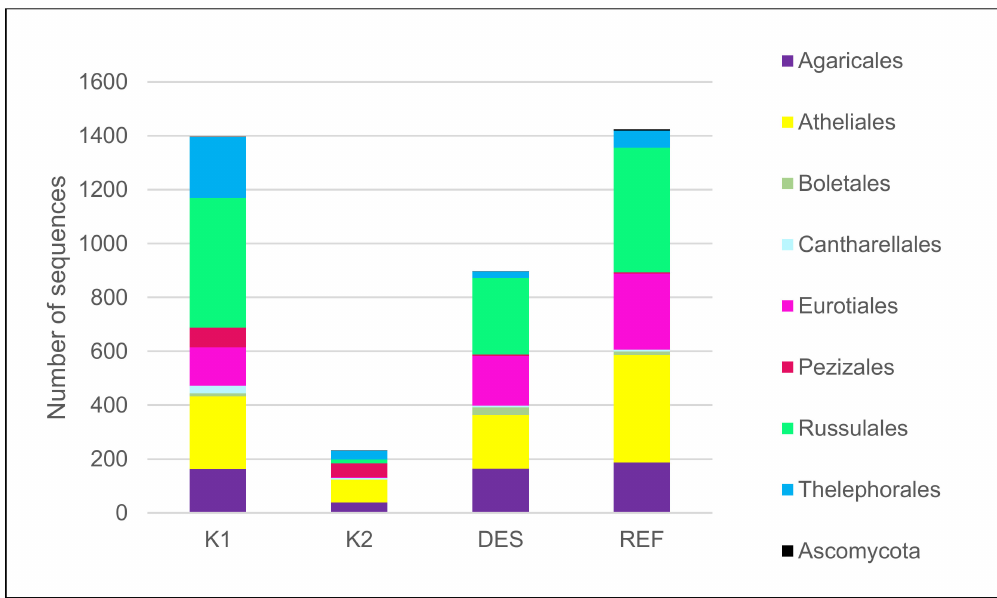
Figure 4. ECM fungal taxonomic composition assigned to ECM orders as noted by average absolute sequence abundance from 10 microsites per forest that is attacked by bark beetle (K1), destroyed by bark beetle (K2), with removed trees (DES), and mature